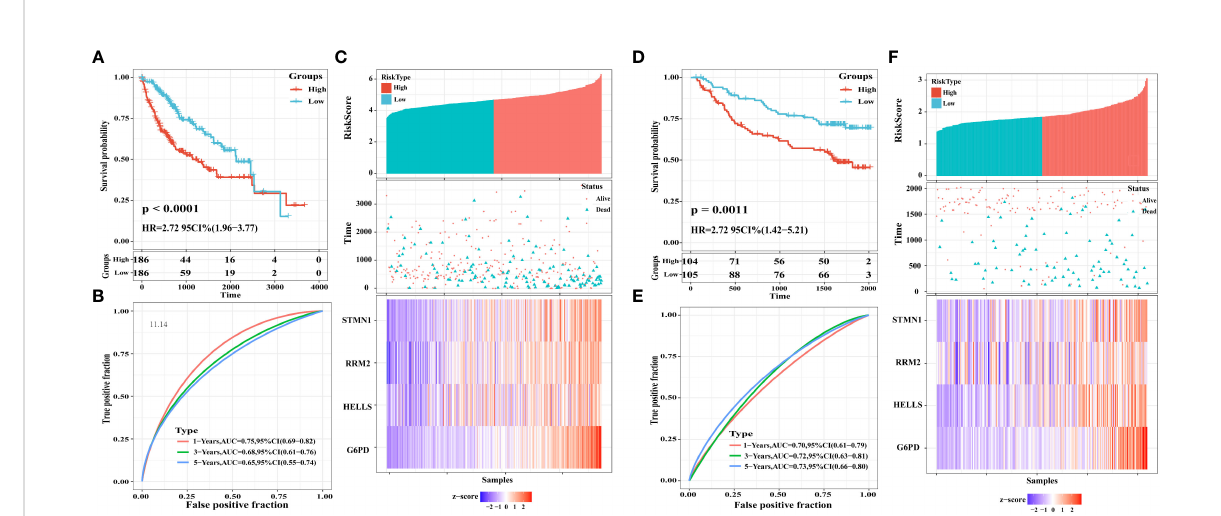
FIGURE 7 Construction and validation of a four-FRGs prognostic risk signature. (A) Distribution of the four-FRG signature in Kaplan-Meier survival curve for the TCGA-LIHC training set. (B) ROC curve and AUC for predicting OS. (C) TCGA-LIHC training set focused on risk score, survival time, survival status, and expression of the four-FRG signature. (D) Distribution of the four-FRG signature in the Kaplan-Meier survival curve for the GSE14520 validation set. (E) ROC curve and AUC for predicting OS. (F) TGSE14520 validation set focused on risk score, survival time, survival status, and expression of the four-FRG signature.